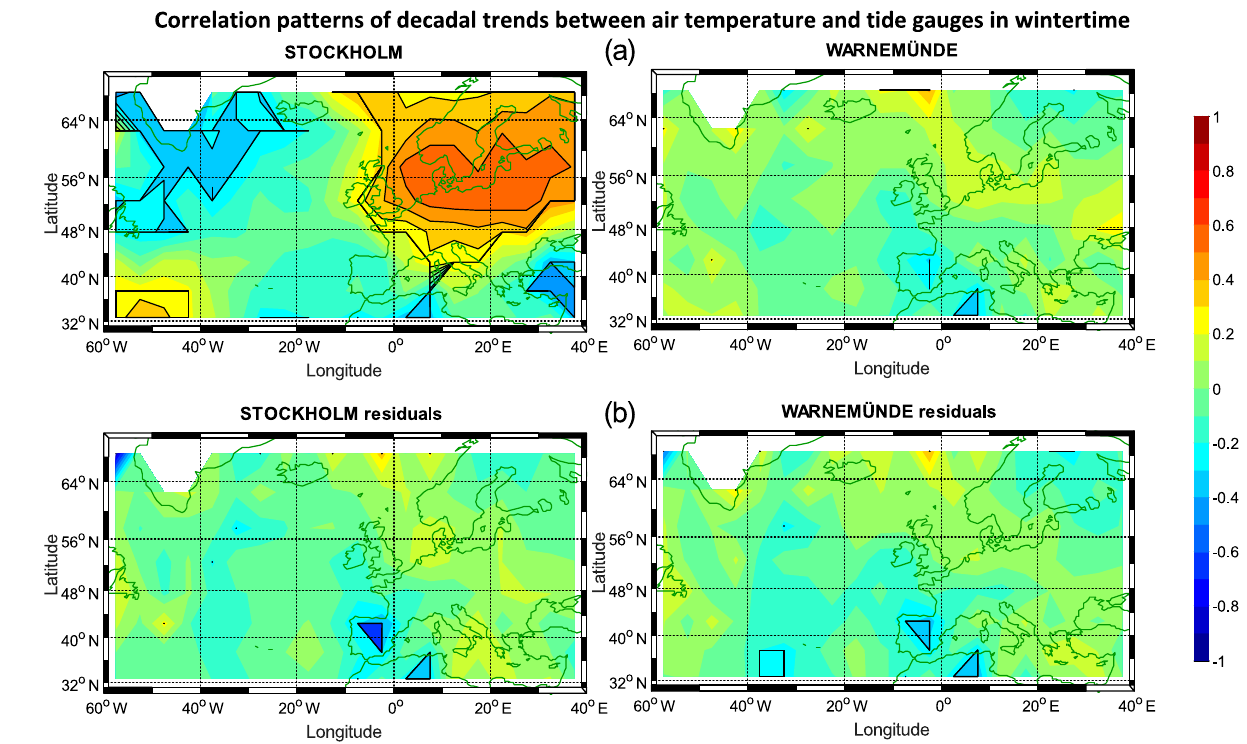
Figure 7. The correlation patterns between air temperature and the sea-level records at Stockholm and Warnemünde before (a) and after (b) removing the atmospheric signal from the sea-level records in wintertime. The areas indicating significant correlations are delineated with contour lines. The 95% significance level is ± 0.19 for this record